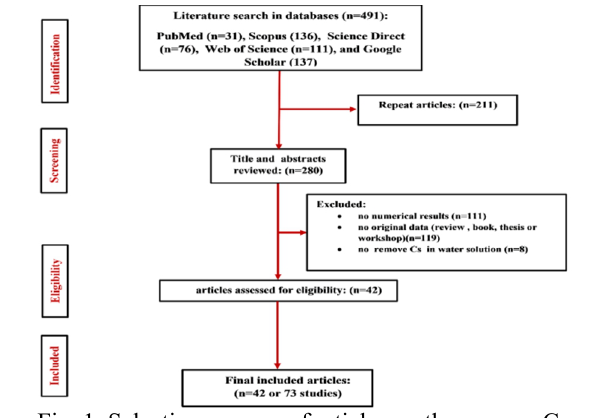
Fig. 1. Selection process of articles on the remove Cs from aqueous solutions by adsorption